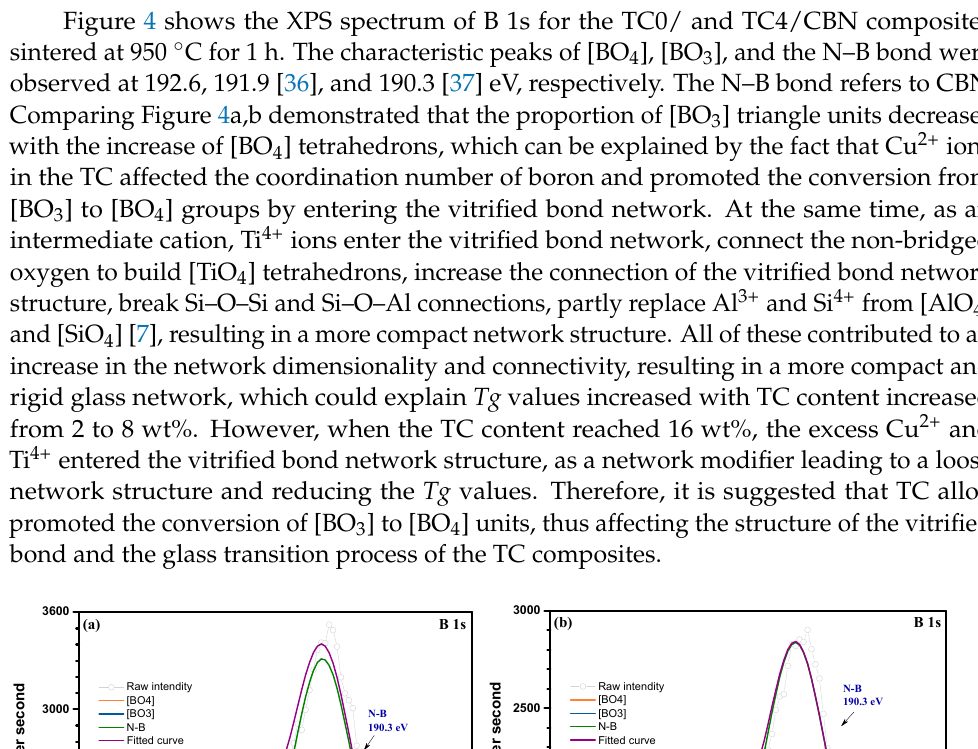
Figure 3. DSC curves of the TC composites with different TC contents at a heating rate of 10 °C/min (i) glass transition temperature of CS 4, (ii) Tg values of the TC composites with different TC con- tents.